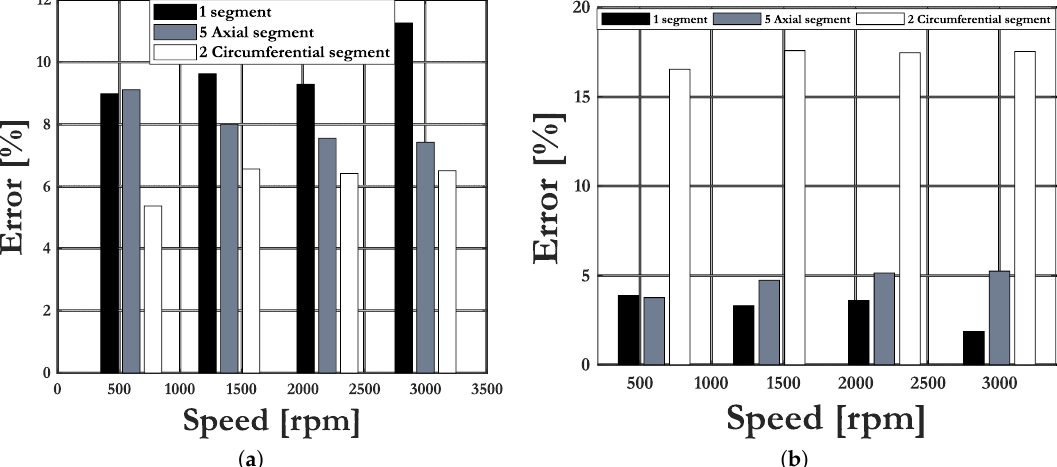
Figure 23. Relative error between the hybrid model and 3-D FEA: ( a ) all paths, and ( b ) middle path of